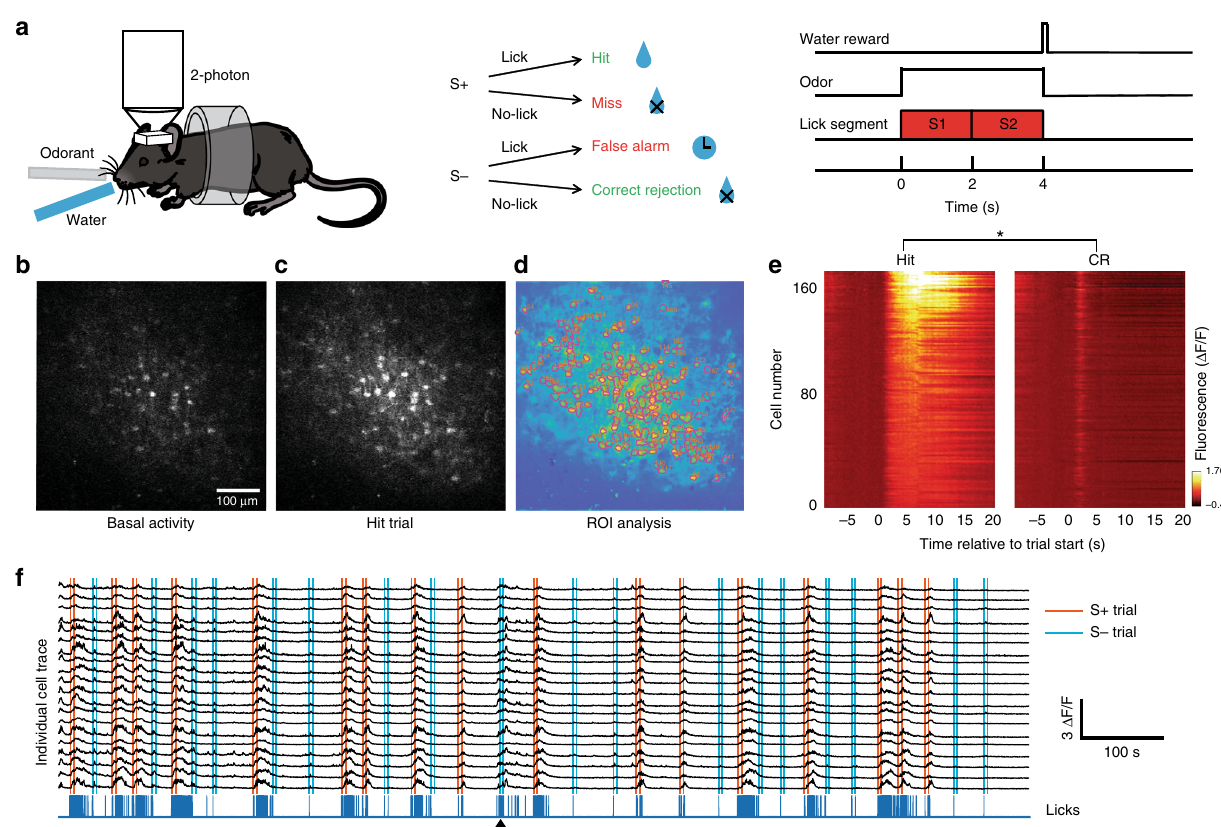
Fig. 1 Two-photon Ca 2 + imaging of MLIs in head- fi xed mice. a go – no go task. Left: Two-photon imaging of a head- fi xed mouse responding to odorants by licking on a water spout in response to the rewarded odorant in the go – no go task. Center: Scoring of decision-making. Right: time course of the trial. For water reward in Hit trials the animal must lick at least once in each of the two 2 s lick segments. b – d The panels in b and c show two-photon microscopy images of GCaMP6f fl uorescence recorded from MLIs in a mouse pro fi cient in the go – no go task (basal activity: before trial start, Hit trial: during reinforced odorant application). The color image in d shows the regions of interest identi fi ed using CaImAn software 31 . e Pseudocolor plots displaying the average per trial Δ F / F time course for Hit (left panel) and CR (right panel) odorants for all ROIs in this example. GLM analysis involving time periods pre-odorant (1 s before odorant onset), odorant (last second during odorant application) and reinforcement (1.5 s after reinforcement), and different events (Hits, Miss, CR and FA) yielded signi fi cant differences between reinforcement and pre-odorant ( p < 0.001), between odorant and pre-odorant ( p < 0.001), and between all interactions between these two period pairs and all events ( p < 0.01, 2040 observations, 2028 degrees of freedom, n = 170 ROIs, 1 mouse, GLM F-statistic 234, p < 0.001). *Post-hoc ranksum p < pFDR = 0.048. f Neural ensemble activity. Black traces are the GCaMP6f fl uorescence ( Δ F / F ) time courses for a application, light blue is S − . The blue trace at the bottom shows the licks. All trials were Hits or CRs with the exception of the trial identi fi ed with the